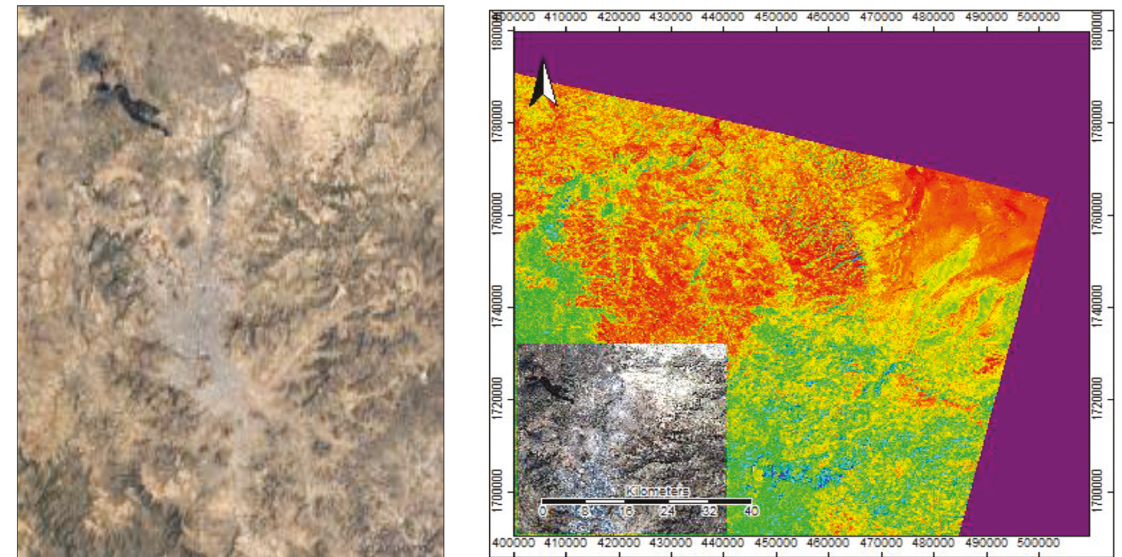
Figure 3: Sana’a on Google map and dataset of Sentinel-2A